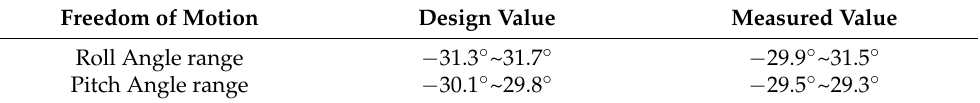
Table 2. Design and measured values of the workspace of the platform prototype.